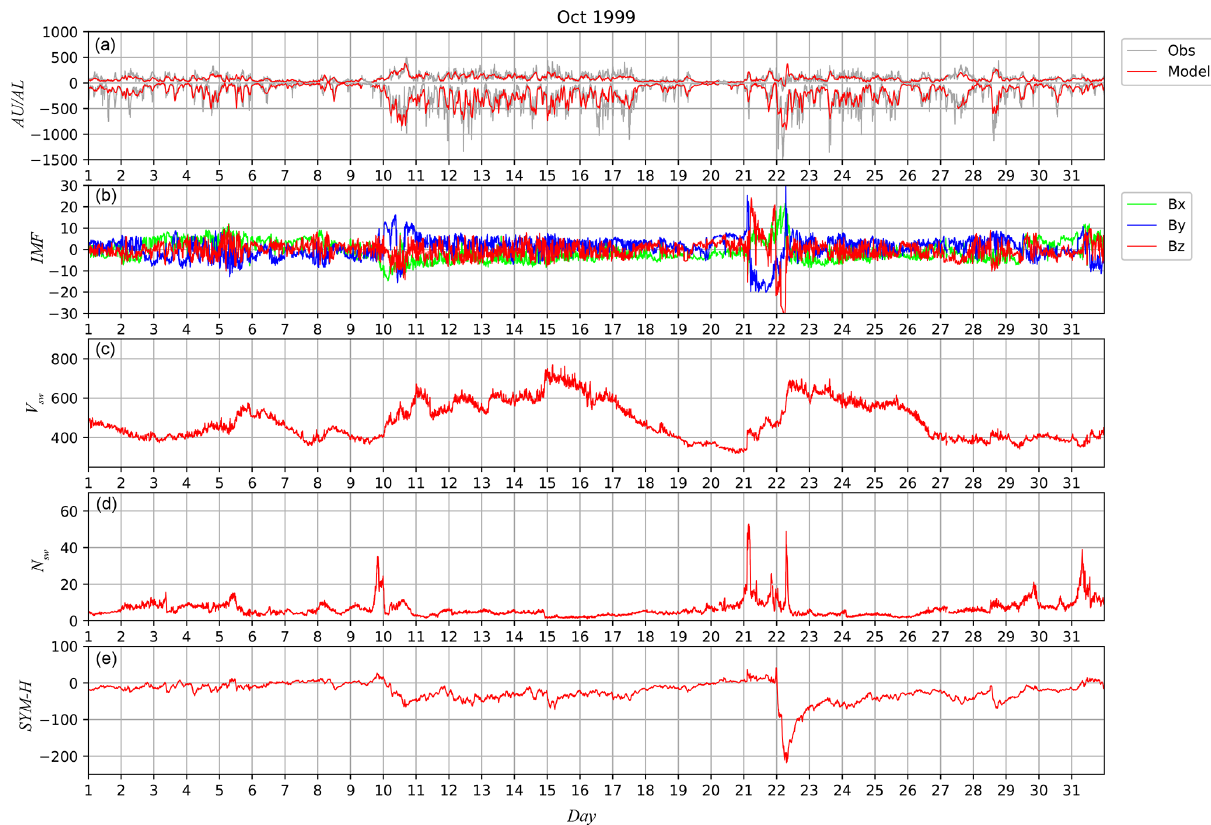
Figure 1. Panel (a) shows the AU and AL values for October 1999 reproduced with the ESN model (red) and the observed AU and AL indices (gray). Panel (b) shows the IMF B x (green), B y (blue), and B z (red) in GSM coordinates. Panel (c) shows the solar-wind speed, panel (d) shows the solar-wind density, and panel (e) shows the SYM-H index.